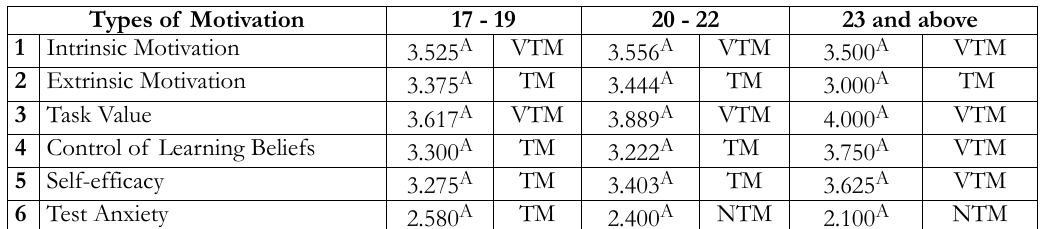
( 1 Means of the same letter within rows are comparable at .05 level of significance